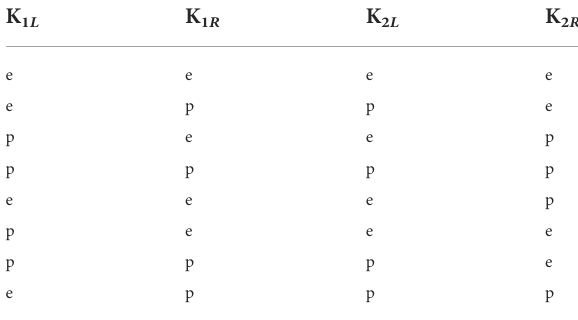
TABLE1Eightdifferentcasesoftwoadjoiningkinktailcon fi gurations. Here, e denotes an exponential tail and p denotes a power law tail (see text for